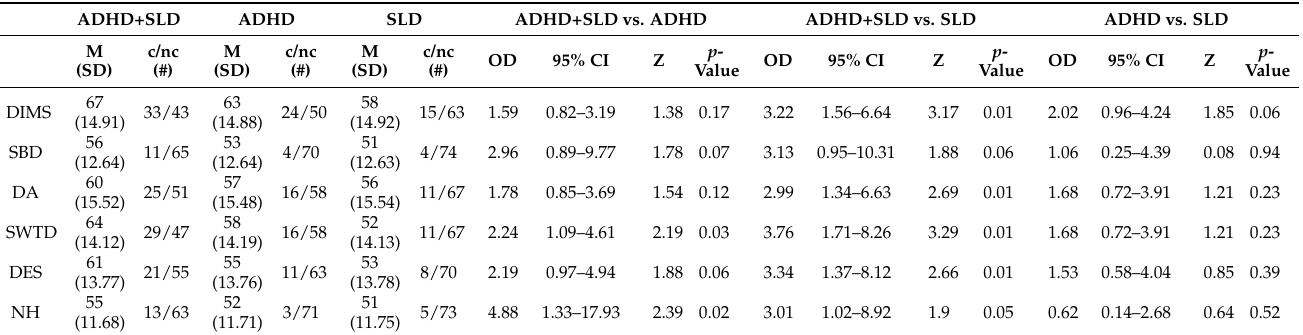
Table 1. Frequencies of children and adolescents with clinical (T-scores ≥ 70) and non-clinical (T-scores < 70) scores and group comparisons on Sleep Disturbances Scale for Children.